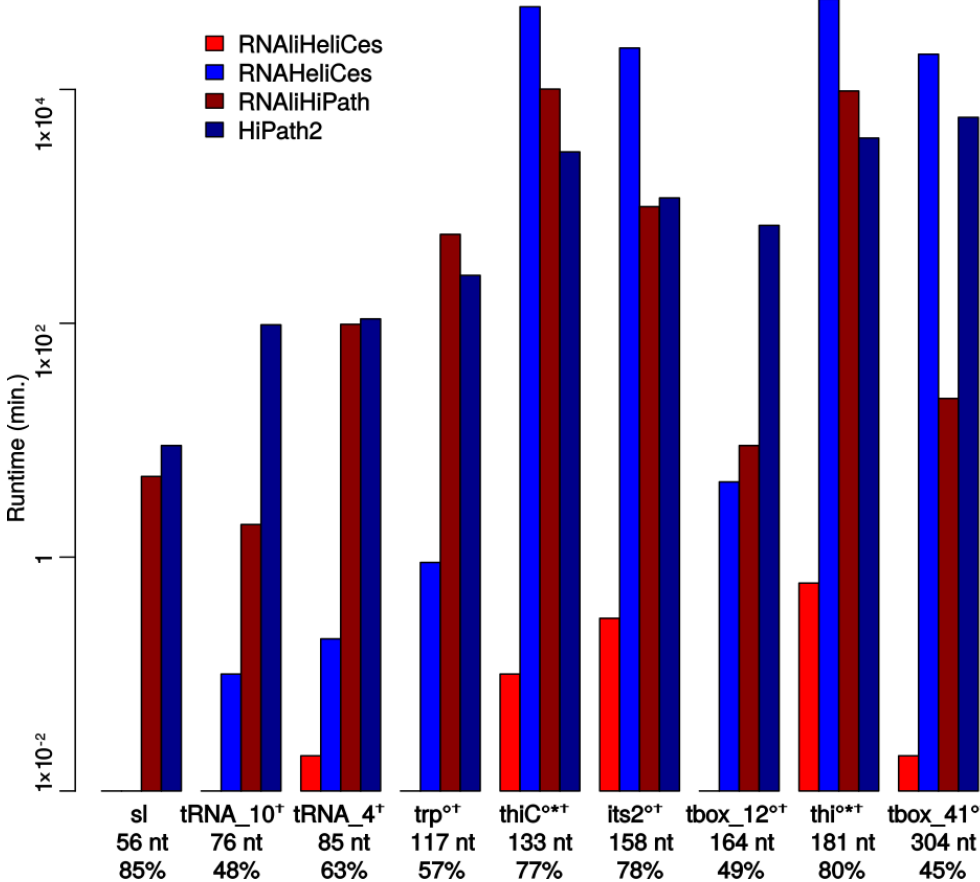
Figure 6. Runtime comparison of RNA LI H I K INETICS (RNA LI H ELI C ES + RNA LI H I P ATH ) and RNAH I K INETICS (RNAH ELI C ES + H I P ATH 2). Run times were measured on a 176x Intel with 768 GB RAM under openSUSE 15.1 (x86_64). For the examples marked with ‘ ◦ ’, only the first 10,000 hishapes in RNAH ELI C ES , for the ones marked with ‘*’, only the pathways between the first 100 hishapes in RNA LI H I P ATH , and for the ones marked with ‘†’, only the pathways between the first 100 hishapes in H I P ATH 2 were calculated. The numbers below the names refer to the length and the mean pairwise identity of the alignments,